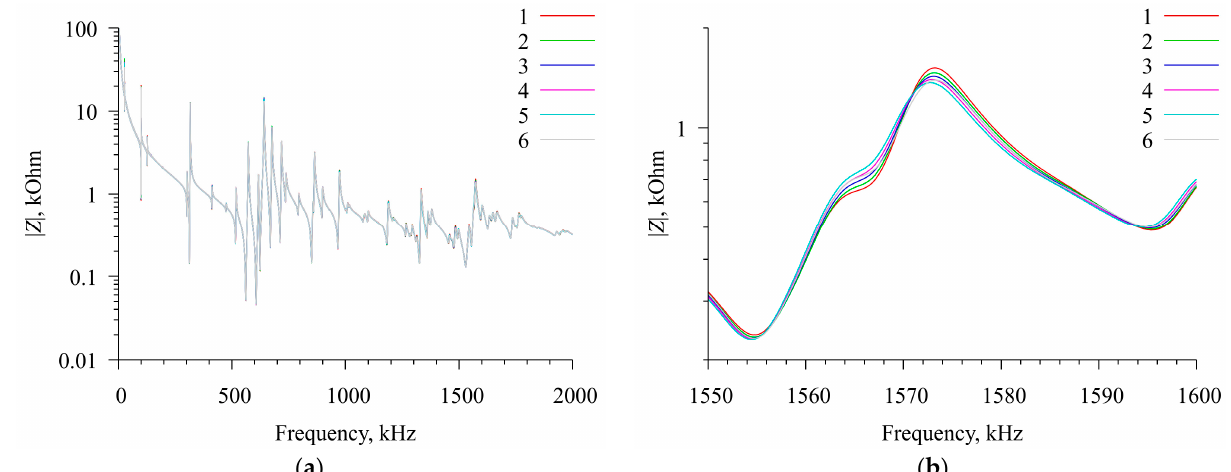
Figure 5. Frequency dependencies of the electrical impedance modulus for a radial electric field excited resonator loaded with a film of chitosan acetate at different times of exposure to ammonia vapors. ( a ) General view of dependencies; ( b ) magnified view in the range of 1550–1600 kHz. Curves 1—0 min, 2—100 min, 3—200 min, 4—300 min, 5—400 min, and 6—480 min from the beginning of the experiment.